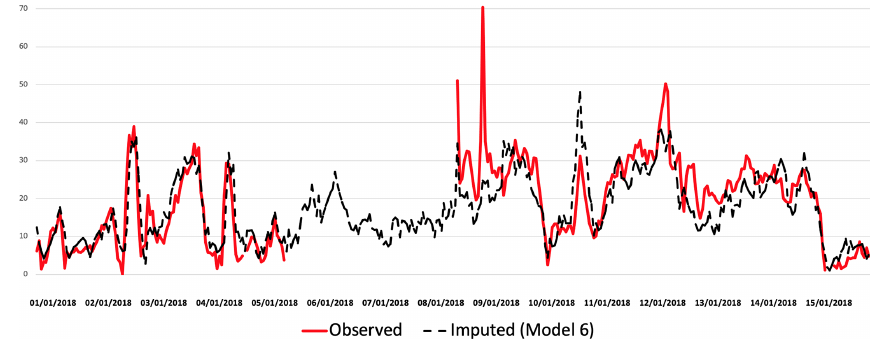
Figure 13. Imputed (black) and real (red) TS comparison for PM 10 at Oxford St Ebbes station from 1 to 15 January 2018.